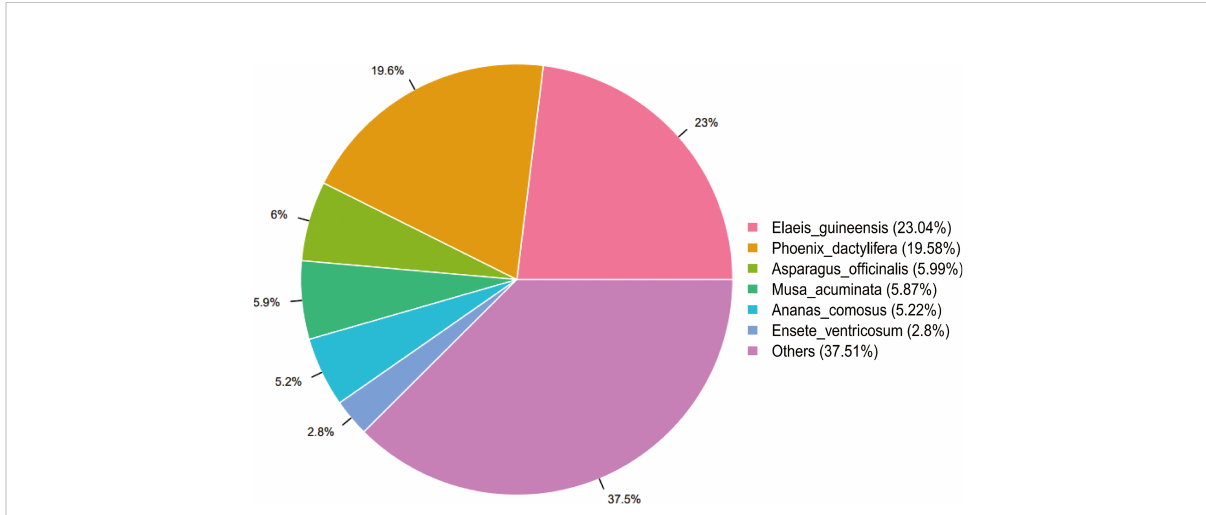
FIGURE 2 Species distribution for the assembled unigenes annotated to NCBI non-redundant protein database (NR). The percentages represent genetic homology degree of assembled unigenes with respective